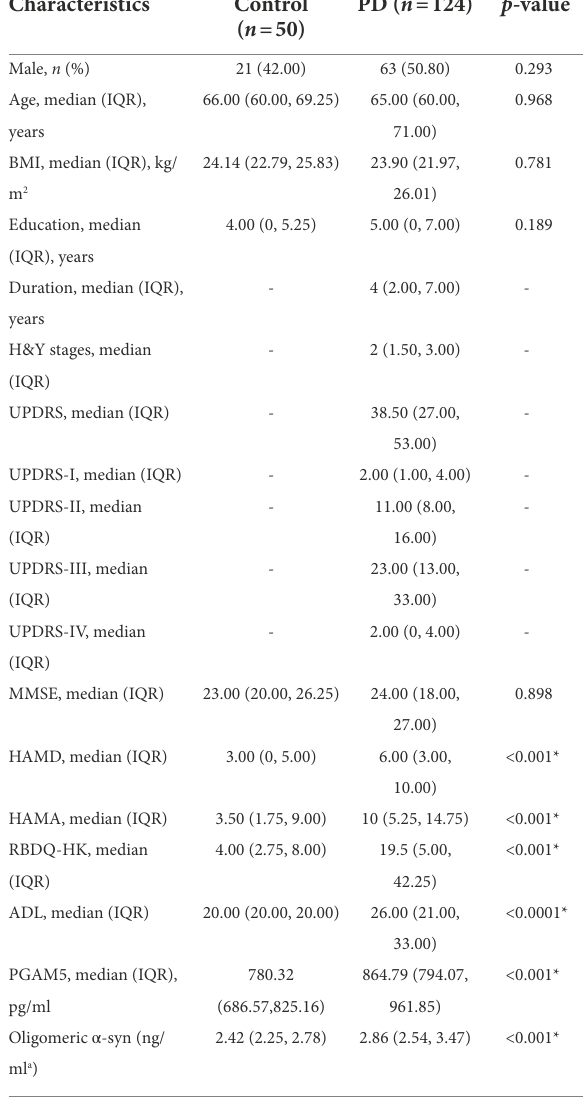
TABLE 1 Basic demographics and clinical characteristics of the participants.